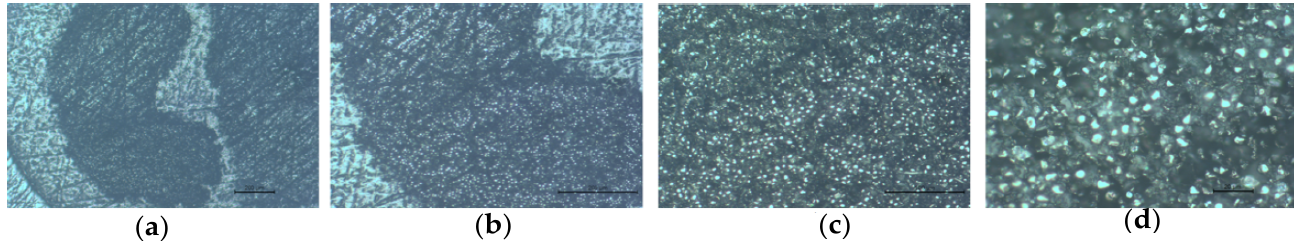
Figure 12. Microscopic view of sample number 5 with different zoom. ( a ) 75 × zoom, scale is 200 µ m; ( b ) 150 × zoom, scale is 200 µ m; ( c ) 300 × zoom, scale is 100 µ m; ( d ) 750 × zoom, scale is 20 µ